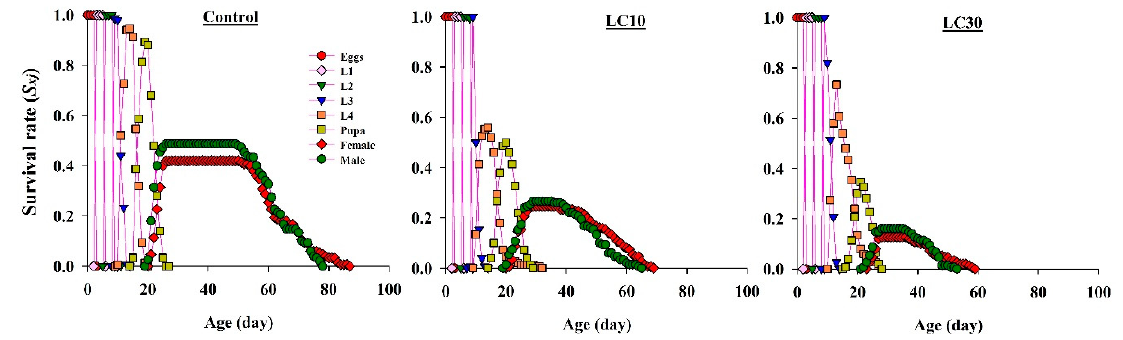
Figure 2. Graphs show sxj (age-stage-specific survival rate) values of offspring produced by Harmonia axyridis females treated with sublethal chlorpyrifos concentrations.